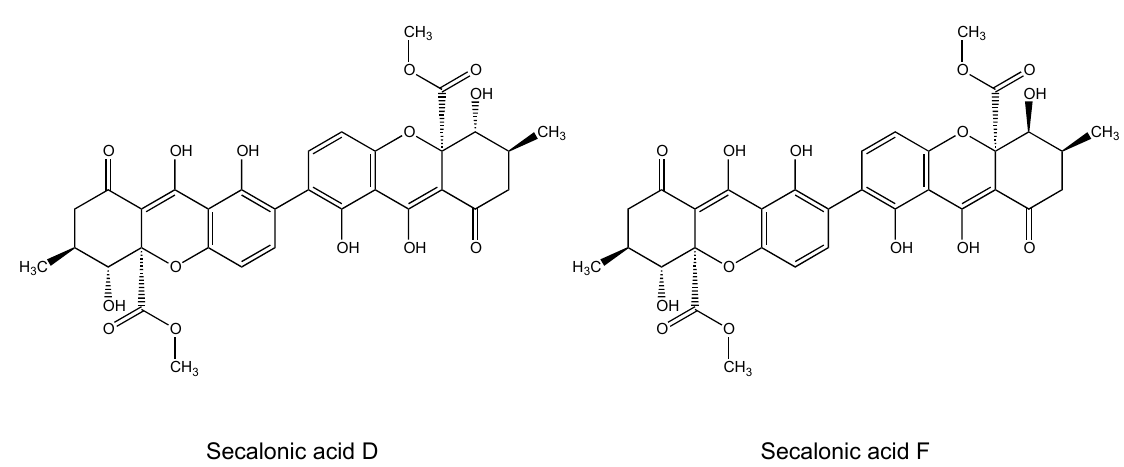
Figure 1. The chemical structures of secalonic acid D and secalonic acid F.